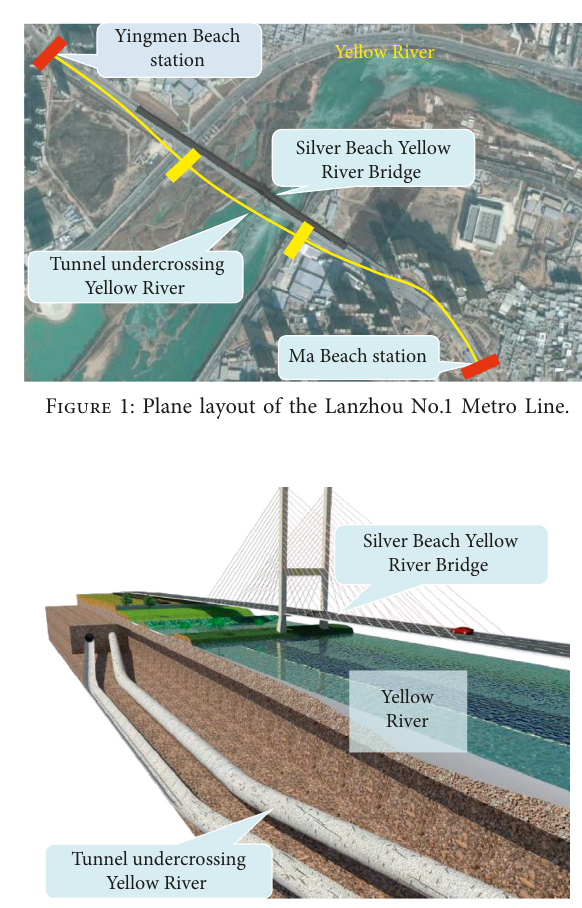
Figure 2: Profile diagram of the tunnels under the Yellow River